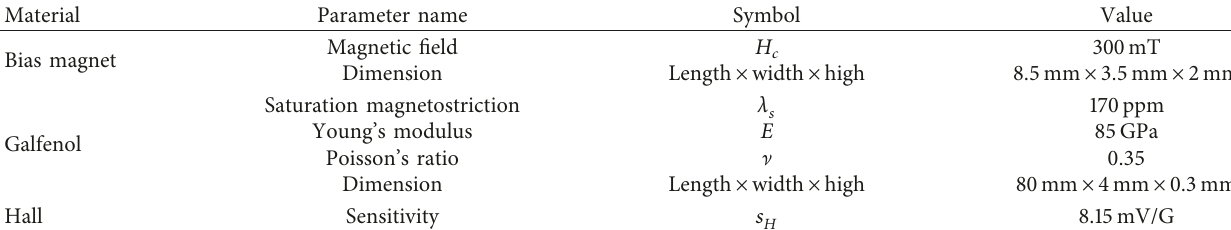
Figure 1: (a) 3D model and (b) photograph of Galfenol whisker sensor. Table 1: Physical and geometrical parameters of Galfenol whisker